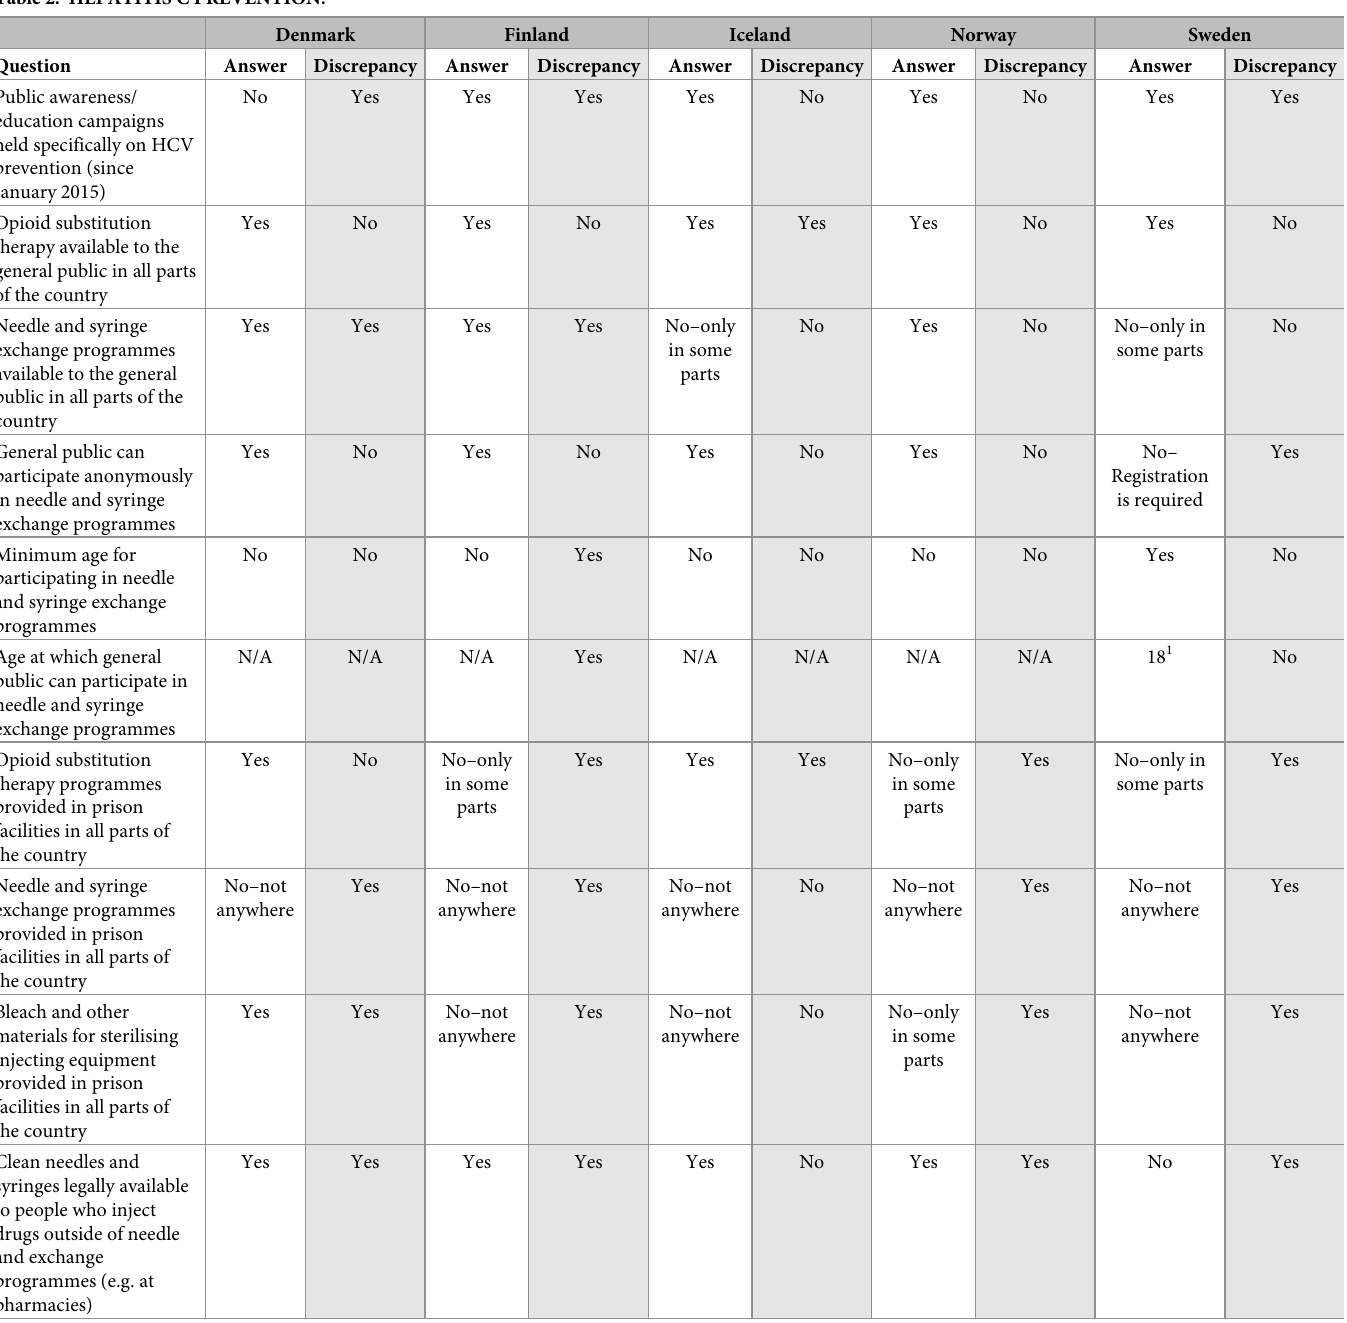
Table 2. HEPATITIS C PREVENTION. Denmark Finland Iceland Norway